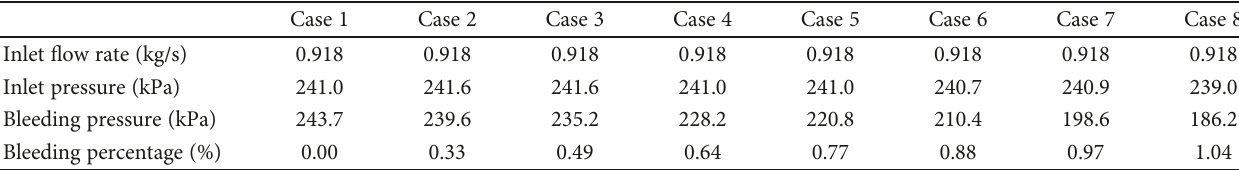
/ H = 1 73, T = 30 ° C ). 2 1